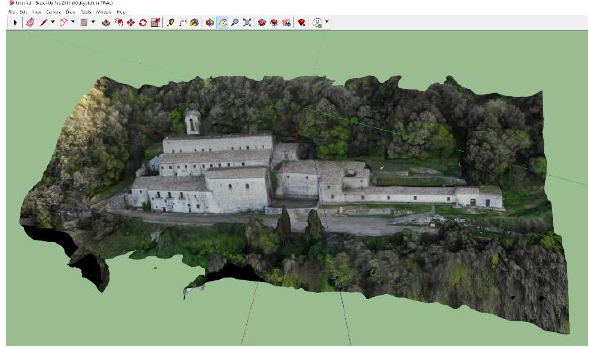
Figure 7. The decimated model on the SketchUp environment Consequently, the model was published to the GE platform and